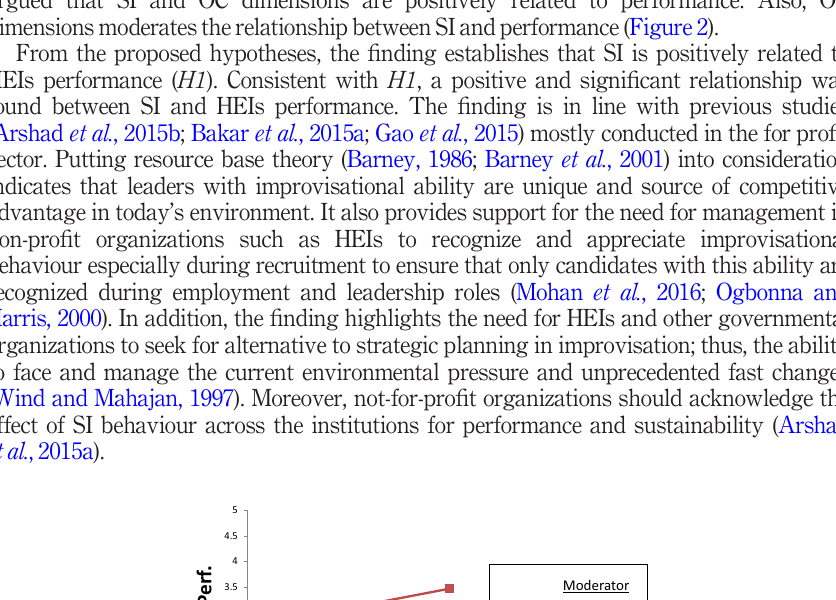
Figure 2. Interaction effect of IC with SI on